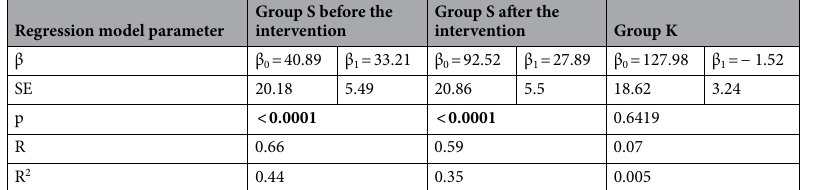
Group S before the intervention